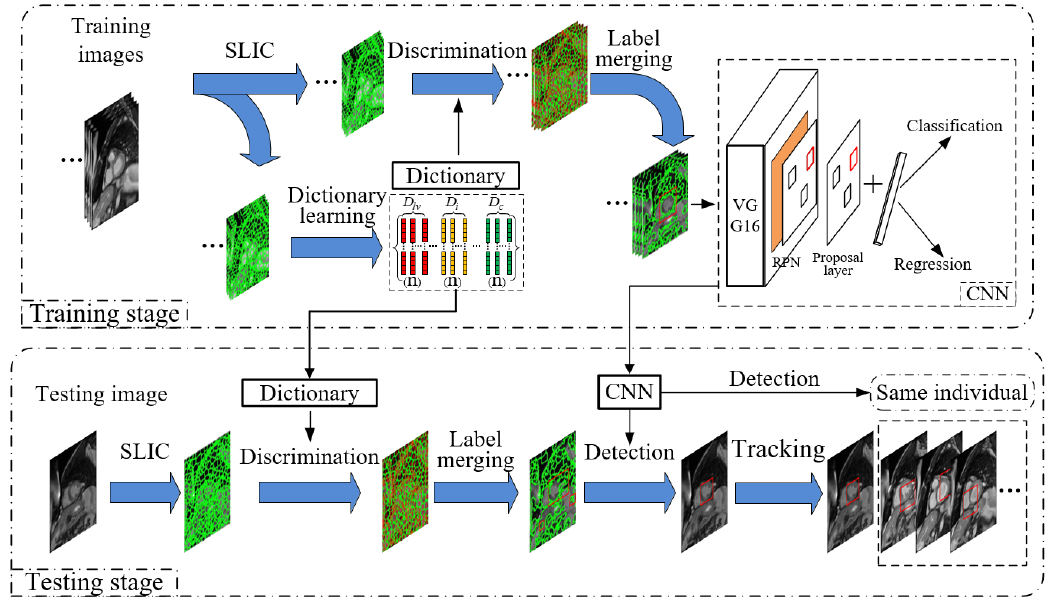
Figure 3. Overall framework of proposed left ventricular detection method, including modules of learning discriminative dictionary to classify superpixel regions, constructing left ventricular candidate regions through label fusion, generating scale adaptive anchors in candidate regions, and mapping to RPN and proposal